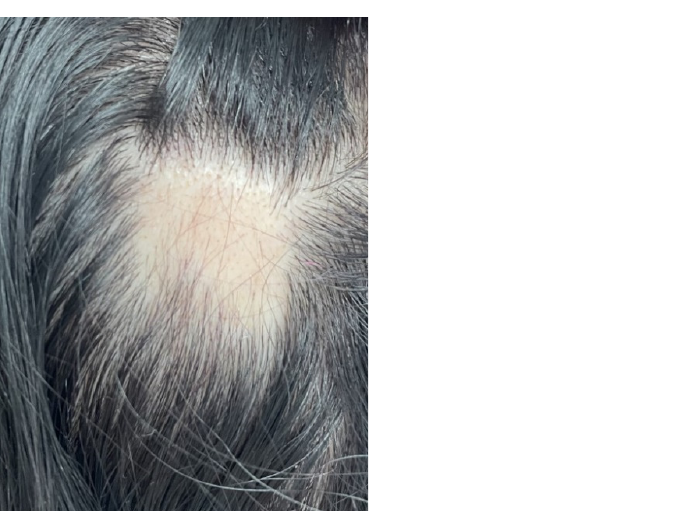
Figure 2. Trichoscopy aspect of alopecia areata; this is a 25-year-old female patient confirmed with Hashimoto’s thyroiditis and normal thyroid function (TSH of 2.27 µUI/mL, normal between 0.5 and 4.5 µUI/mL, high TPO-Ab of 109 UI/mL, normal <35 UI/mL). 3.2. Androgenic Alopecia Female androgenic alopecia, currently called female pattern hair loss (FPHL), is a nonscarring diffuse type caused by a progressive miniaturization of hair follicles and subsequent reduction of hair numbers, particularly in the central, frontal and parietal scalp regions, representing the most common cause of hair loss in adult females (general population) [23,24]. Some subgroups are at higher risk, especially seniors. One cross-sectional study from 2022 on menopausal women (N = 200, aged between 50 and 65 years) showed a 52.2% prevalence concerning FPHL which might be an additional con- tributor to impaired quality of life in menopause, thus the importance of awareness [25]. Whether thyroid disorders with an increasing prevalence in the aging female population are incidental or represent a pathogenic loop is not clear. We mention one prospective study on FPHL (aged between 20 and 88 years) that identified a hypothyroidism ratio of